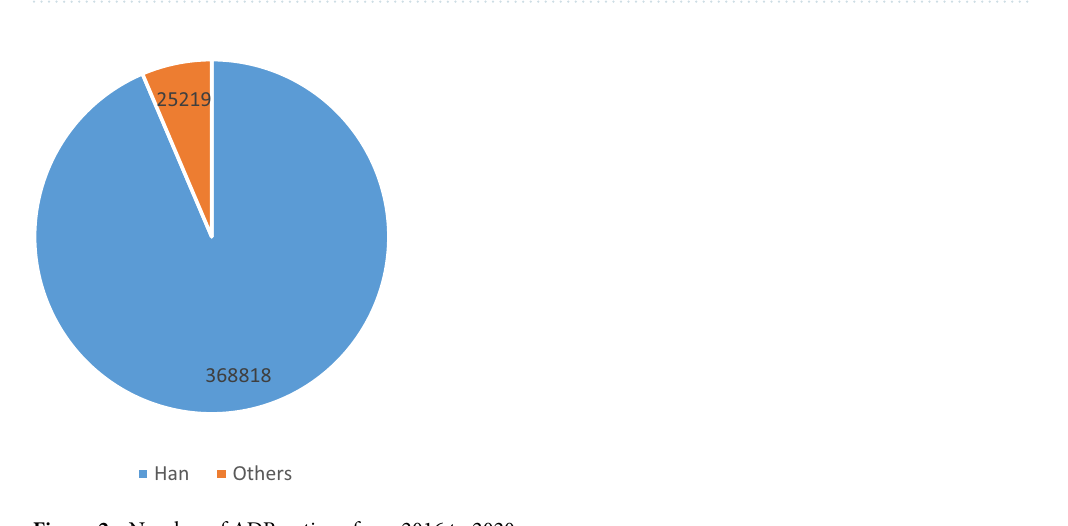
Figure 2. Number of ADR nations from 2016 to